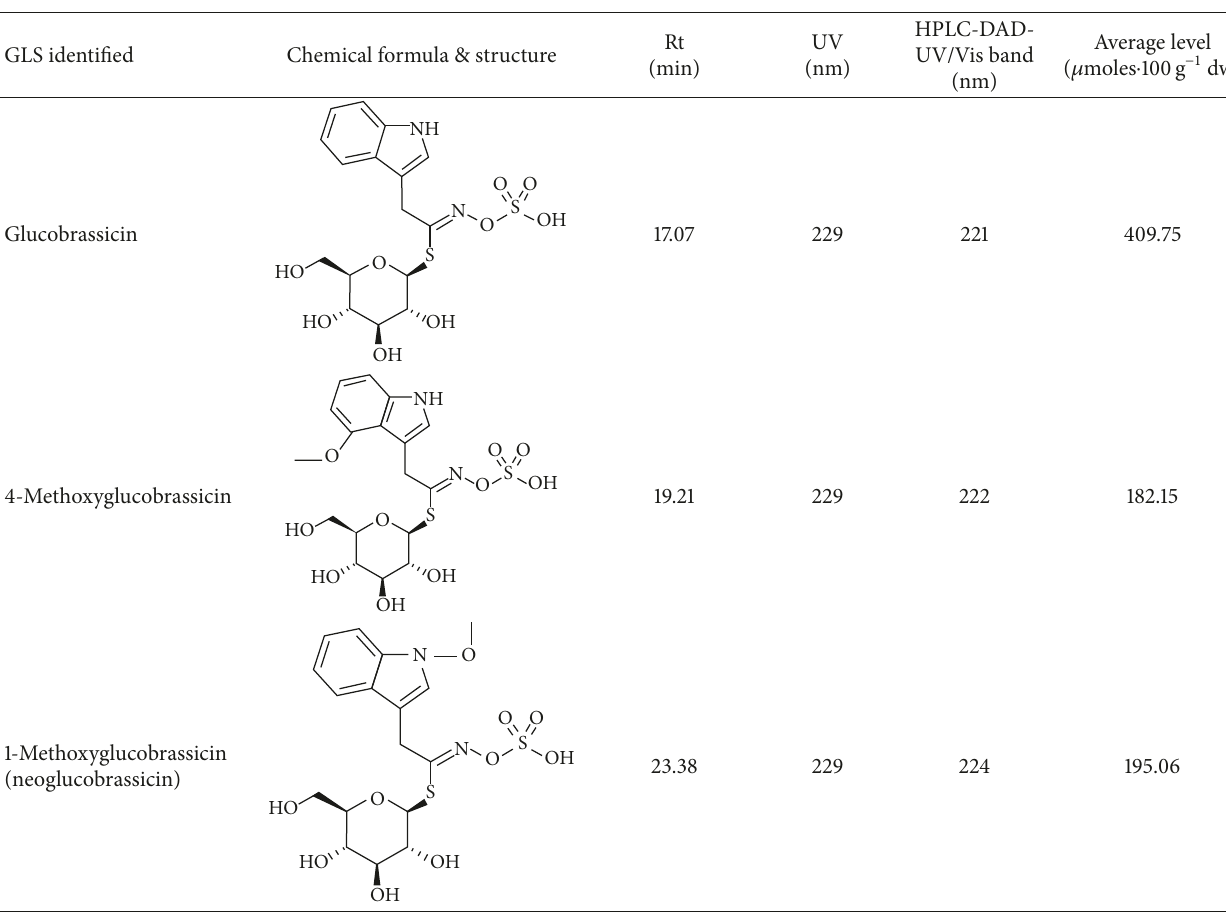
Table 4: Glucosinolates identified in the current Chinese hairy roots. Respective retention time (Rt). Wavelengths of maximum absorption in the visible region by elution order and respective average content.